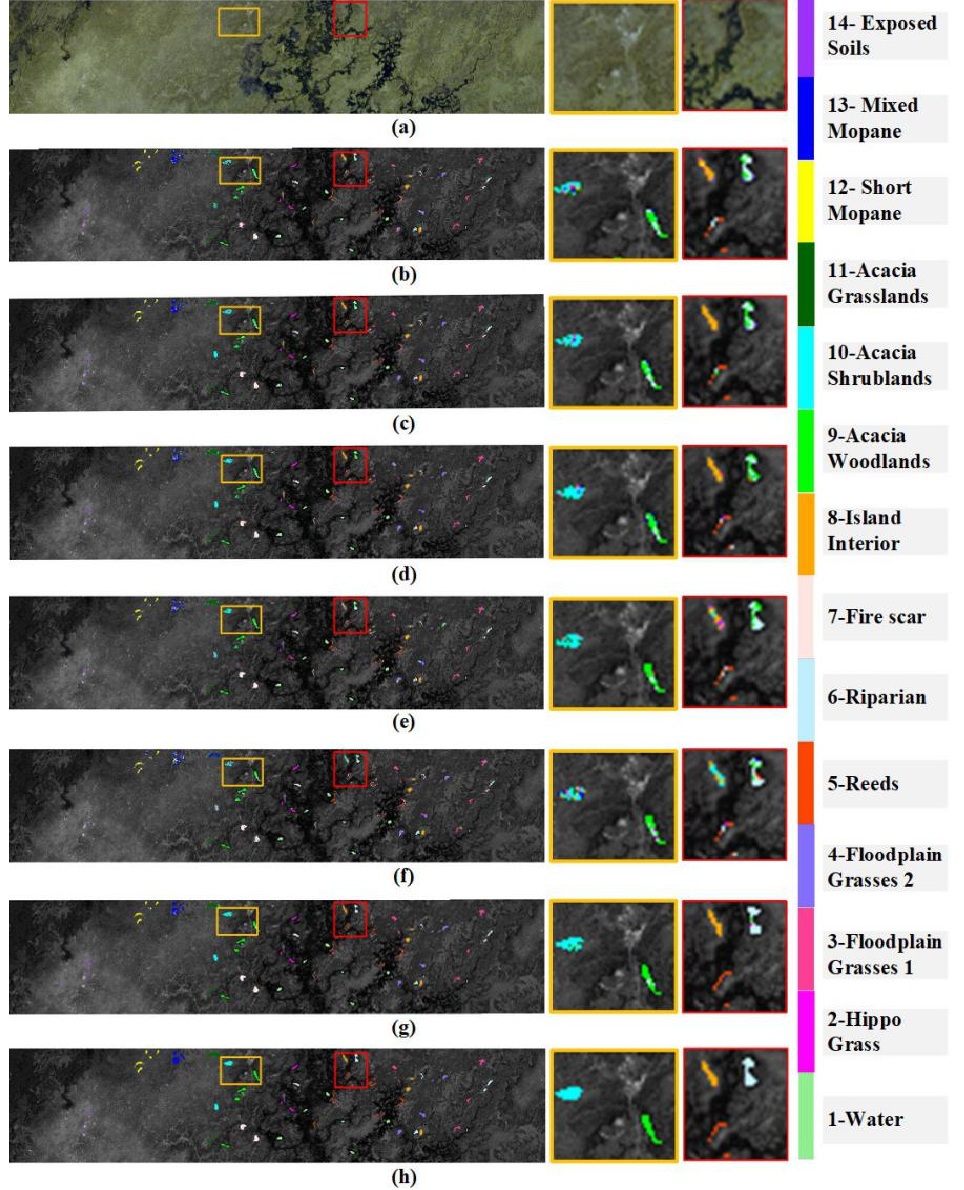
Figure 10. Classification map for the Botswana dataset with methods in comparison: ( a ) pseudo-color image; ( b ) FDDL; ( c ) DPL; ( d ) ResNet; ( e ) RNN; ( f ) CNN; ( g ) ours; ( h ) ground truth. Rectangles colored as red and yellow represent mountain and grassland